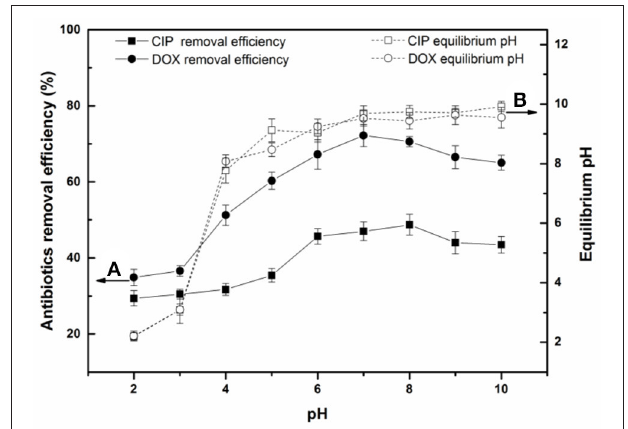
FIGURE 2 | (A) Effect of solution pH on the adsorption of DOX and CIP by BC700; (B) Relationship between the initial and equilibrium pH of the sample solution (initial concentration = 40 mg/L; sorbent dose = 0.4 g/L; temperature = 298K; contact time =